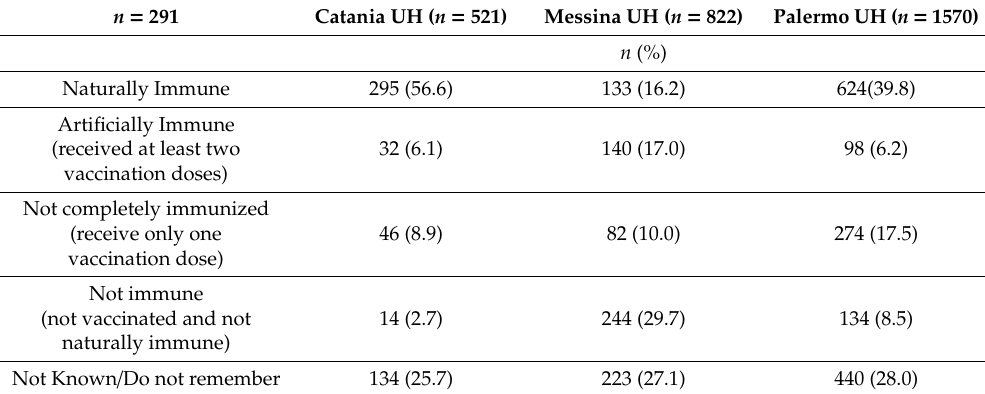
Table 2. Immunization and vaccination status against measles of HCWs surveyed in the three Sicilian university hospitals (UHs).